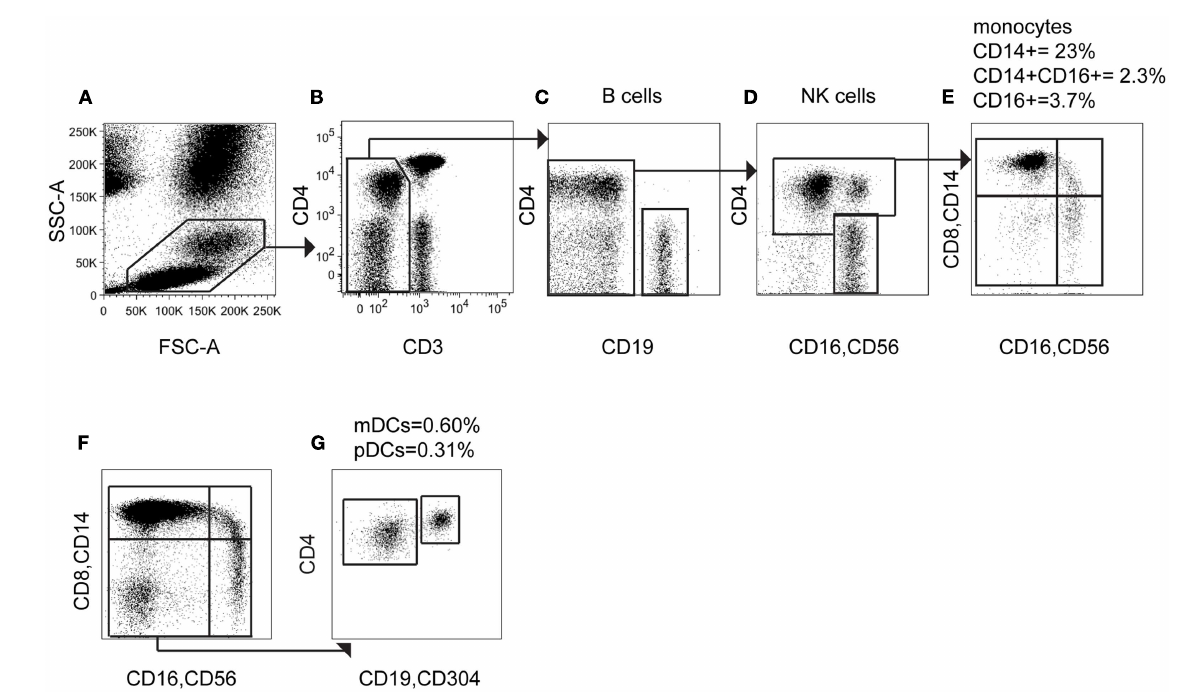
FIGURE 2 | Using CD4 as a lineage marker allows monocytes and DCs to be counted with a 6-color immunophenotyping panel . (A) In a 6-color immunophenotyping panel modified by addition of CD14 antibody, mononuclear cells are gated based on FSC and SSC parameters. (B) CD3 negative cells, including DCs and monocytes, B cells and NK cells are gated out fromT cells. (C) CD19 + B cells are removed from the CD3 −